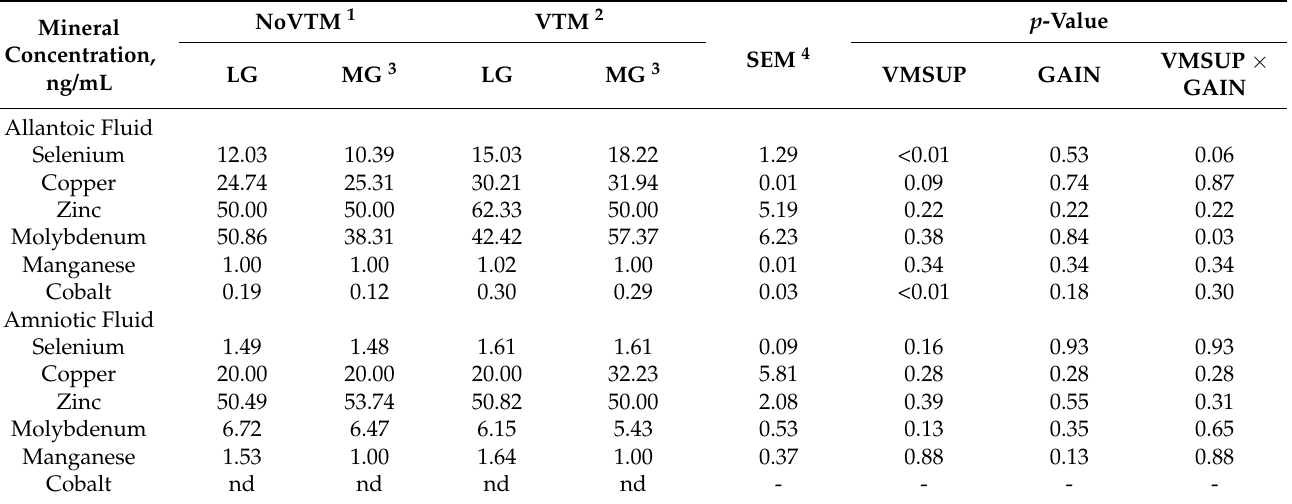
Table 6. Concentrations of trace minerals in allantoic fluid and amniotic fluid from beef heifers at d 83 of gestation as influenced by maternal vitamin and mineral supplementation (VMSUP) and two